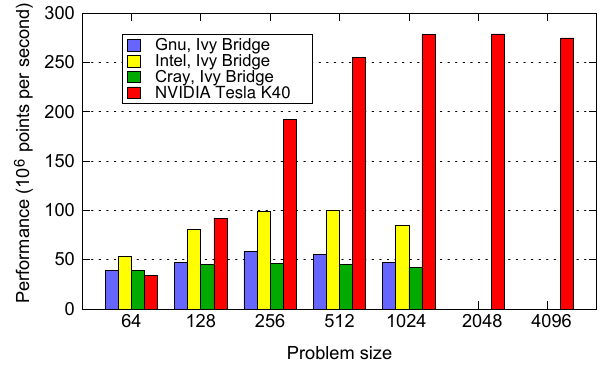
Figure 12. Performance of the best OpenMP-parallel version of PSyKAl NEMOLite2D (on a single Intel Ivy Bridge socket) com- pared with the PSyKAl GPU implementation (using